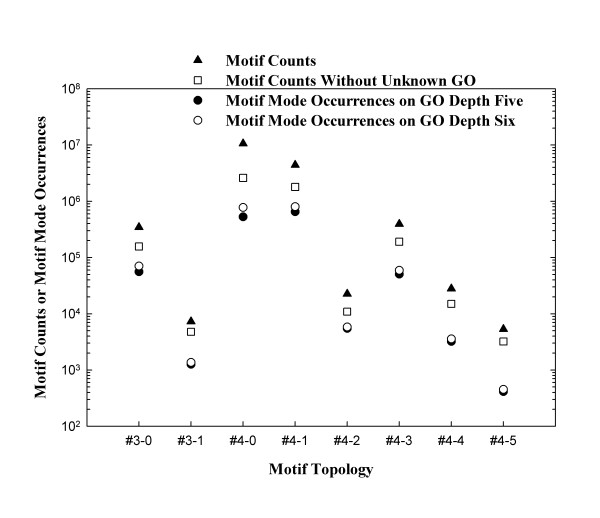
Frequencies of motif topologies and motif modes in the yeast PPI network. Motif counts (in filled triangles and open squares) of eight motif topologies and occurrences (in filled and open circles) of the motif modes of each motif topology on a semi-log plot. If the motifs containing the protein nodes of which the GO annotations are GO:0005554 (function unknown) or have no GO annotation, the motifs were disregarded and plotted in open squares. Occurrences of motif modes are indicated as filled and open circles when the GO terms at depths five and six were employed, respectively.